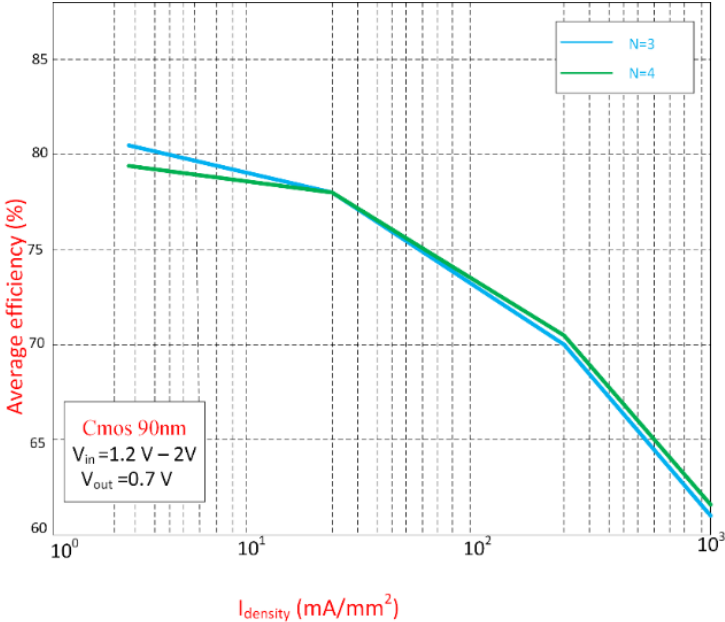
Figure 3. Comparison of a multiratio switched-capacitor converter’s theoretical efficiency (without including switching losses), with N = 2, 3, 4. ‘N’ represents the number of capacitors together with the output capacitor Cout [25]. Reproduced from [25], IEEE TRANSACTIONS ON POWER ELEC- TRONICS:2013.